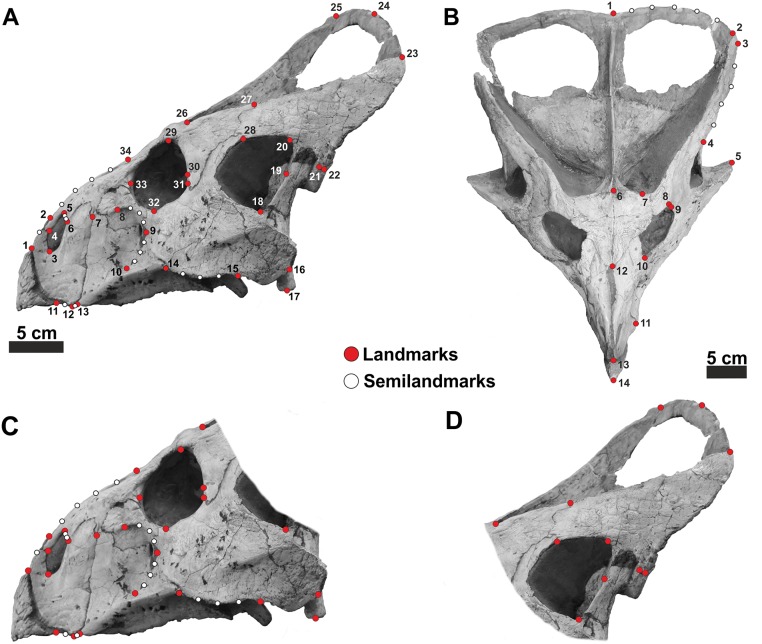
Landmark and semi-landmark configurations.A, landmark configuration for skull in lateral view. B, landmark configuration for skull in dorsal view. C and D are subunits of the skull configuration. Landmarks have identical definitions. See Table C in S1 File for landmark definitions.